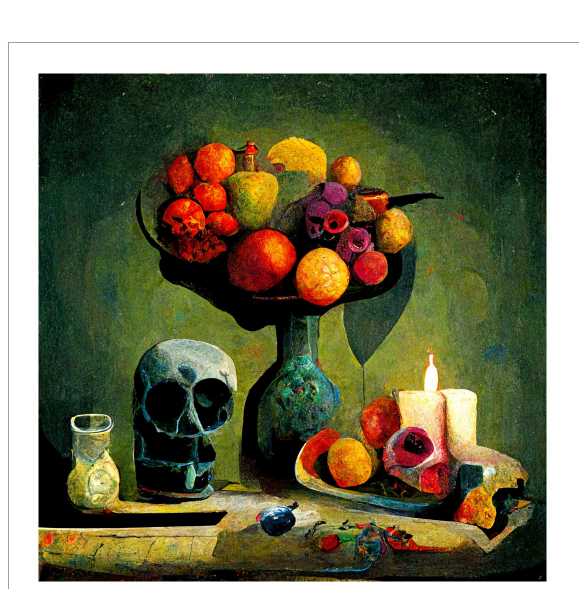
FIGURE4 Midjourney image generated to the prompt “a still life with fruit, flowers, a vase, dead game, a candle, and a skull in a Minimalist